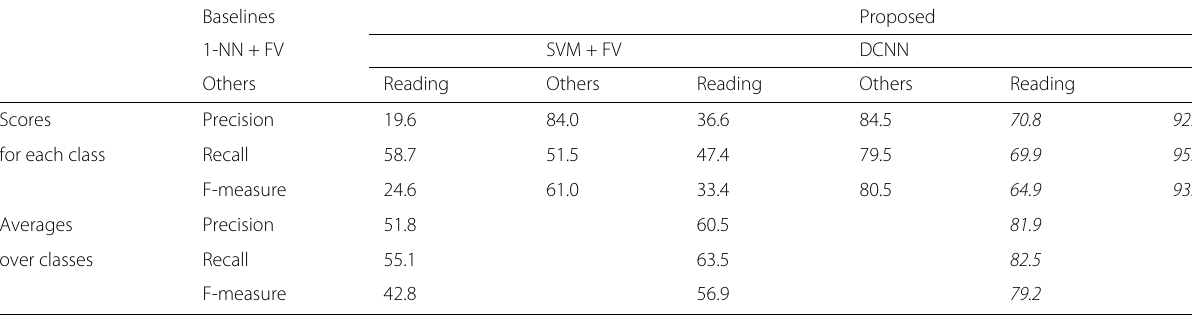
Table 5 Comparative result with our dataset in Table 3 Baselines